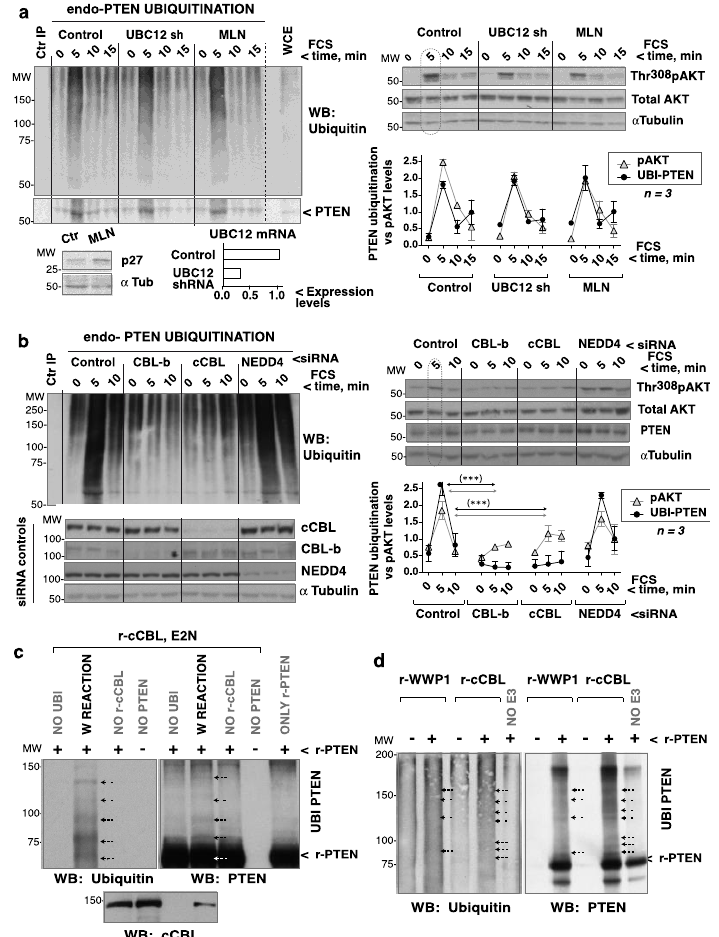
Figure 6. cCBL depletion abrogates GF-induced PTEN ubiquitination. ( a ) HEK-293T were infected with control- or UBC12 shRNA-encoding lentiviruses (72 h), or treated with MLN-4924 (1 μM, 48 h), then incubated in serum-free medium (2 h) before stimulating with FCS (15%) (indicated). Thr308pAKT levels were examined in WCE. Cell extracts were enriched for ubiquitinated proteins by purification in TUBES columns. The eluted ubiquitin-enriched extracts were used for PTEN IP with Ab-fused Sepharose beads. For controls (Ctr IP), extracts were incubated with isotype-matched control Ab beads; PTEN ubiquitination was examined by WB. Dashed lines indicate lanes that were cut out from the original blots (included as Supplementary Information). UBC12 shRNA efficiency was assessed by q-PCR; MLN-4924 activity via the examination of p27kip levels upon cell incubation without FCS (16 h). pAKT signals were measured, corrected for the AKT level, and normalized to the mean pAKT signal in controls (equivalent to 1). The endo-PTEN ubiquitination signal (60–120 KDa) was measured, corrected for cellular PTEN levels (in WCE), and compared to the mean PTEN ubiquitination signal (considered 1). The graph shows the pAKT signal vs. the ubiquitinated PTEN signals (mean ± SD, n = 3). ( b ) HEK-293T cells were transfected with control, NEDD4-1, cCBL, or CBL-b specific siRNA pools (72 h). Cell processing, blots, and graphs are as in ( a ). ( a , b ) * p < 0.05; *** p < 0.001 Chi squared test; the PTEN and pAKT significance levels were similar. ( c ) Duplicate reactions containing purified r-cCBL (200 ng) and GST-PTEN (200 ng) were incubated with ubiquitin, E1 ligase (250 ng), and UBE2N ligase (250 ng) in ubiquitination buffer (whole reaction; W REACTION). Some of the reactions were performed in the absence of ubiquitin, PTEN, or cCBL (indicated). ( d ) Duplicate reactions containing non-phosphorylated r-cCBL or r-WWP1 (200 ng) were incubated in the presence or absence of r-PTEN (100 ng), as well as ubiquitin, E1 (50 ng), UBE2H5B (300 ng), and energy regeneration solution. ( c , d ) Duplicate reactions were examined in parallel WB.